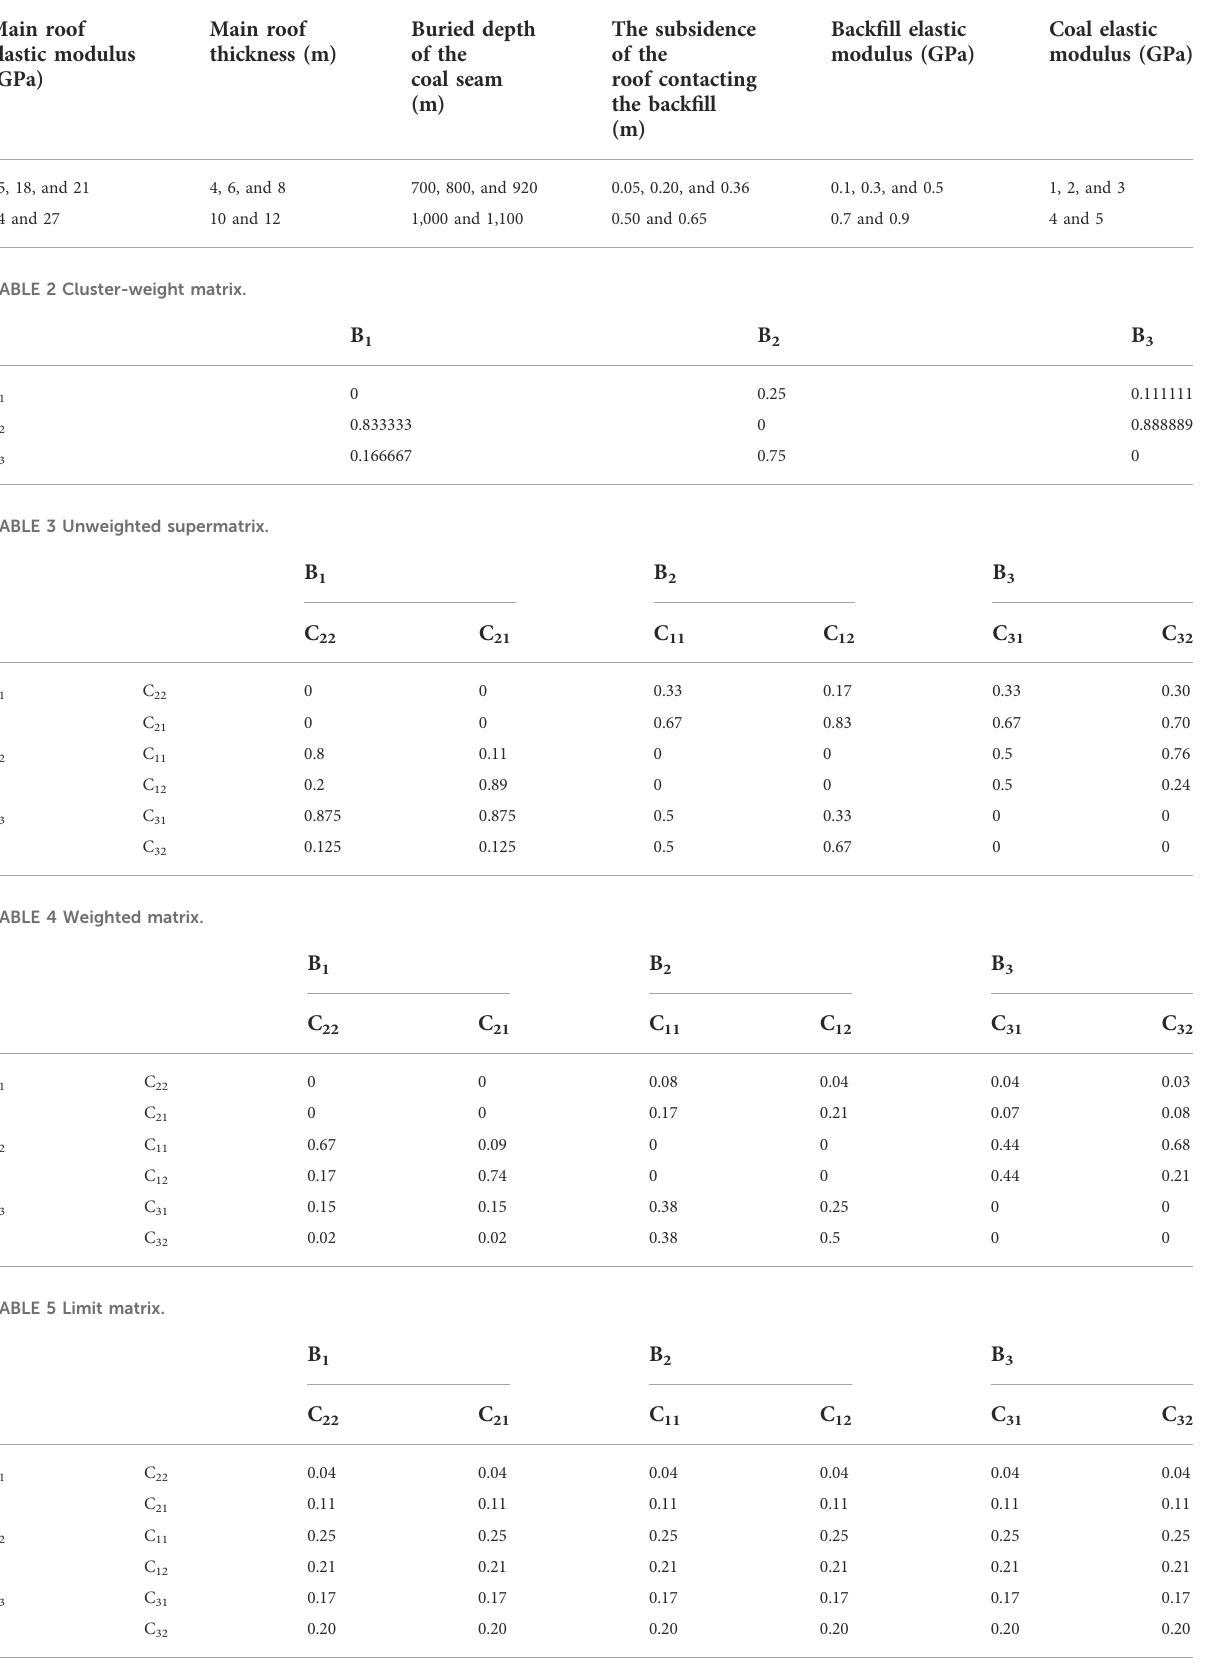
TABLE 1 Mechanical property parameters of different in fl uencing factors.